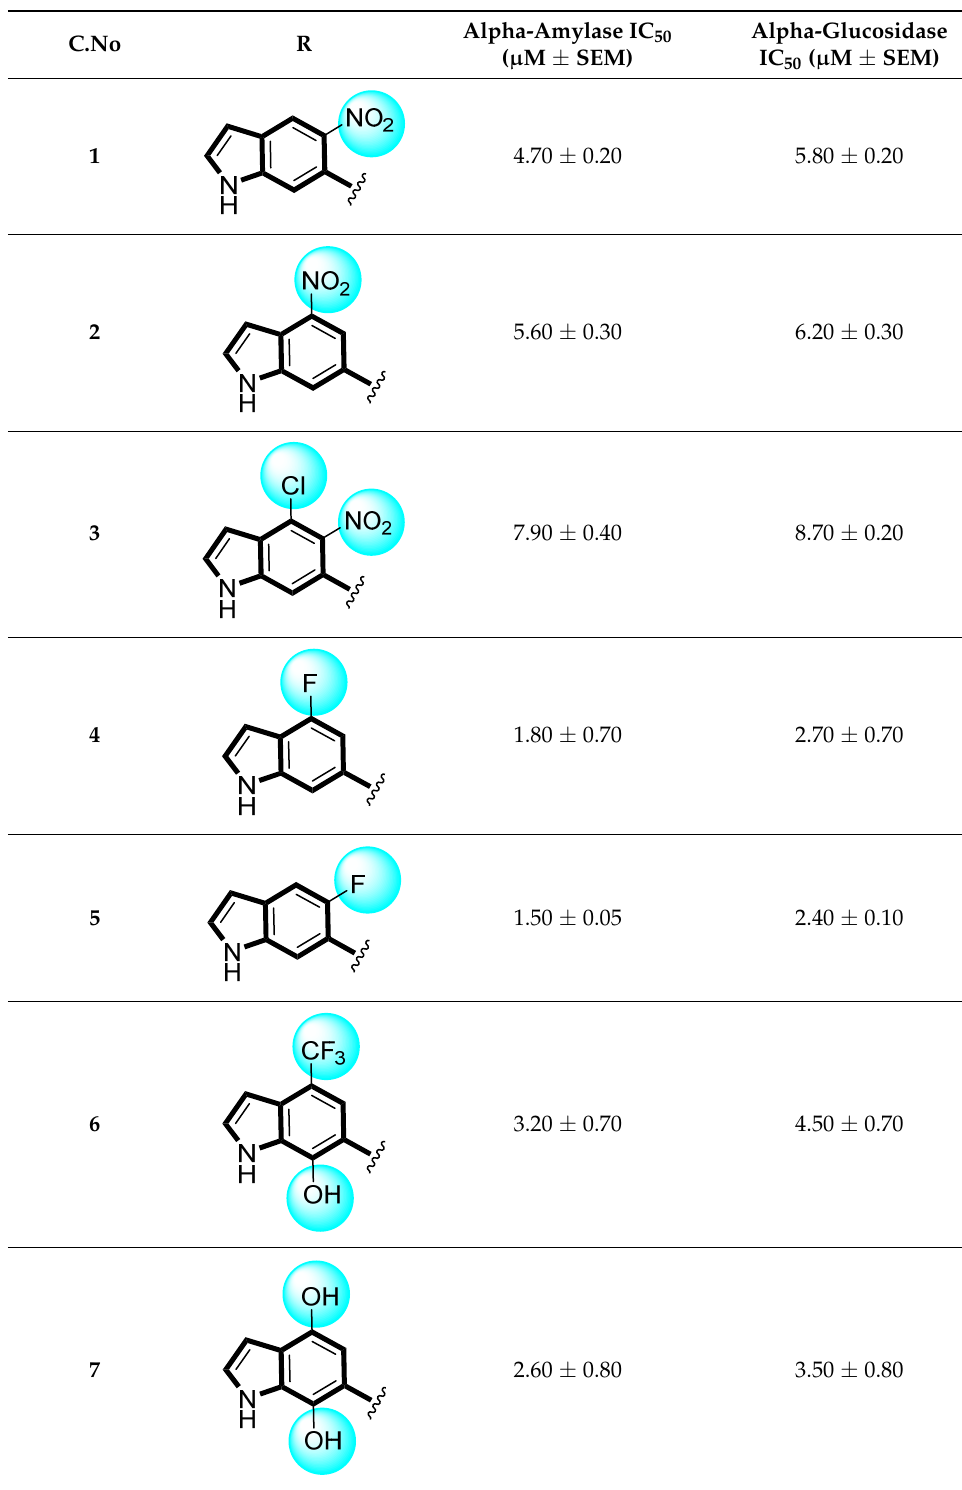
Table 1. Substituted thiazolidinone-based indole derivatives along with biological profile ( 1–20 ).